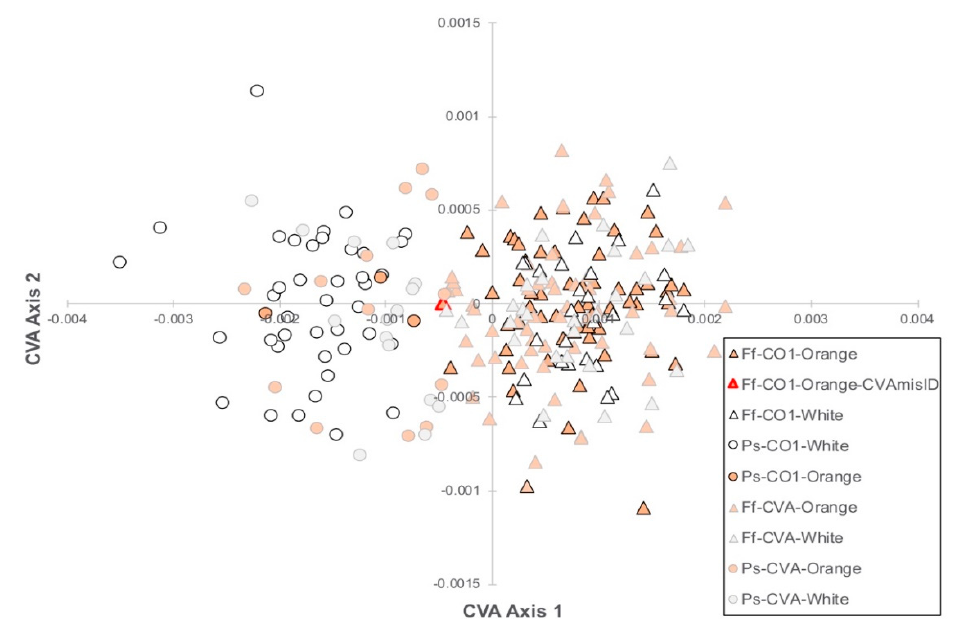
Figure 2. Principal components analysis (PCA) biplot for arcsine transformed shell height/length (H/L), width/length (W/L), width/height (W/H), and hinge length/length (HingeL/L) of F. flava and P. sintoxia specimens.